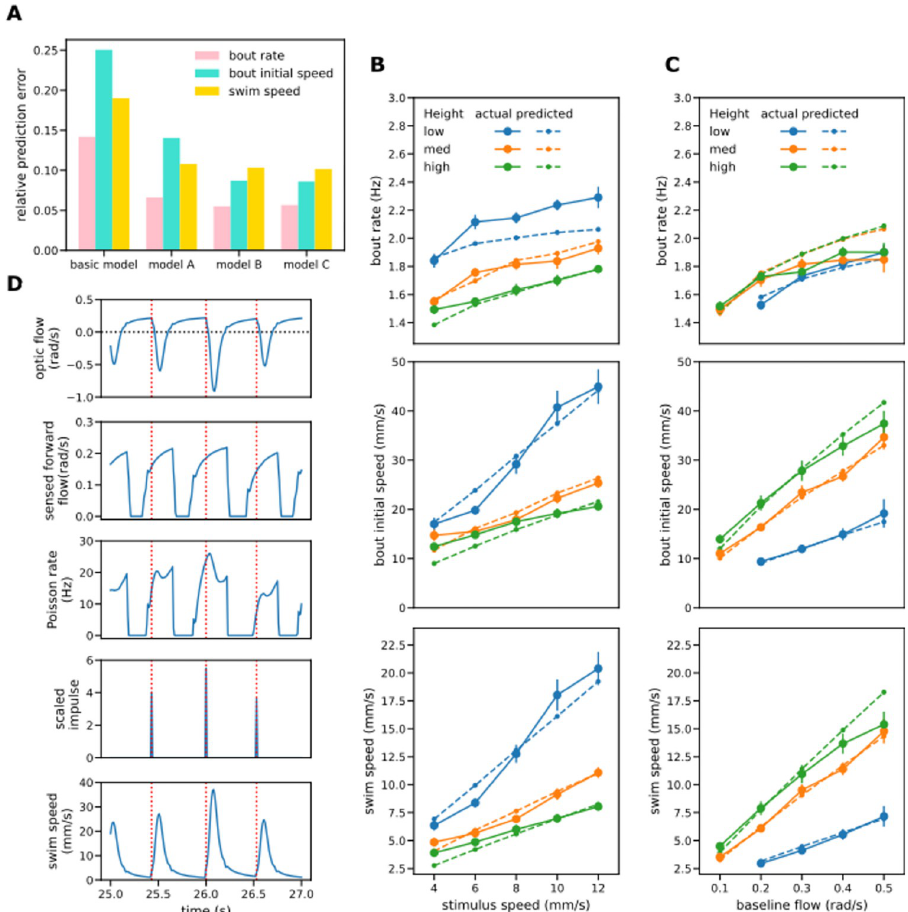
Fig 6. Modeling III: performance of dual factor model. (A) Relative prediction errors for the basic single factor model and the three variants of the dual factor model. All variants of the dual factor model predicted both bout measures and swim speeds better than the single factor model. Variant C that processes only forward flow gave lower prediction errors than variant A and similar ones to the more general variant B, suggesting its adoption as the preferred model. (B-C) Comparison of observed bout rates, bout speeds and mean swim speeds with those predicted by variant C of the dual process model. In general, a good fit is achieved to the observed values for both OMR regulation (B) and the baseline flow procedures (C). (D) Sample signal traces generated by variant C of the two-factor model when height is intermediate (32mm) and stimulus speed 8 mm/s. Red dotted lines indicate times of bout